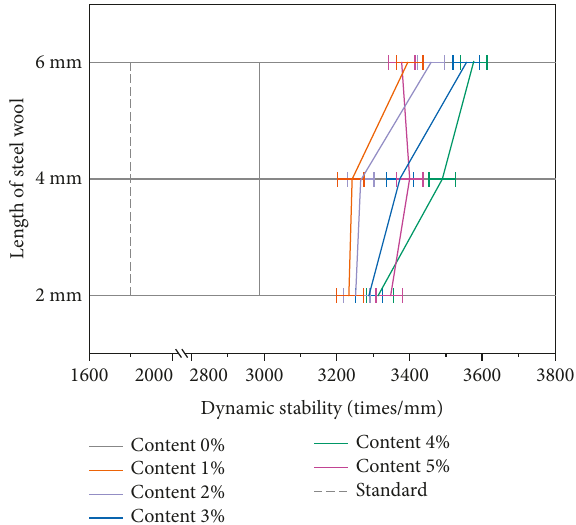
Figure 2: High-temperature performance of steel wool asphalt mixture.